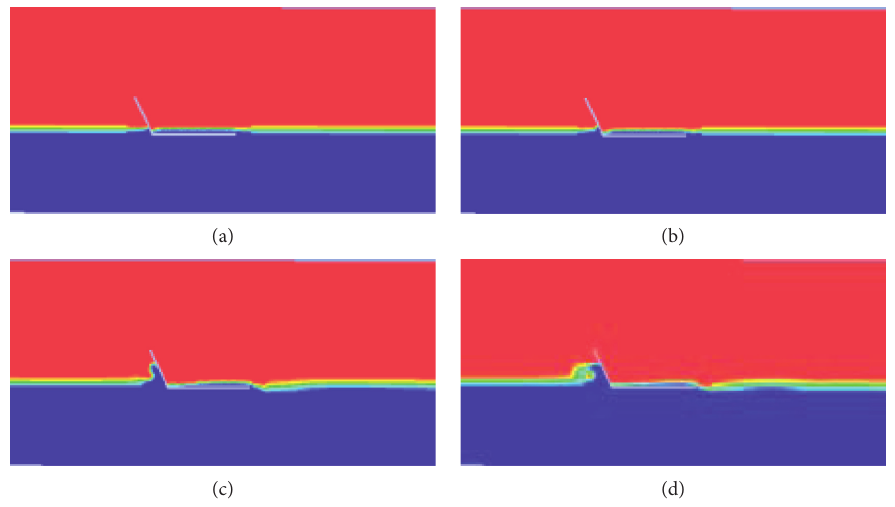
Figure 3: 65 ° floating plate simulation results: (a) 0s, (b) 0.5s, (c) 0.1s, and (d) 2s.